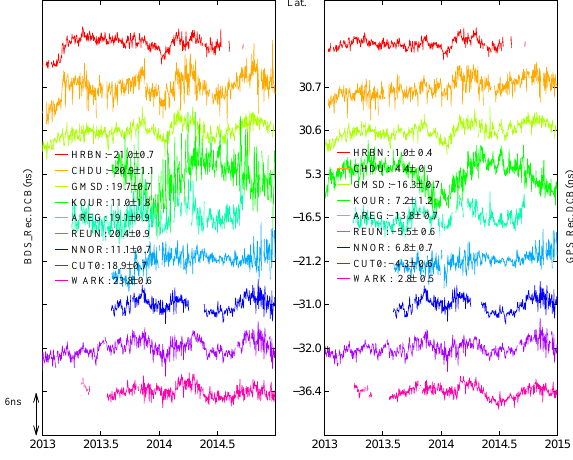
Figure 9. BDS and GPS DCB (C2I–C7I/CIC–C2W) variations in nine stations in the Asia–Pacific